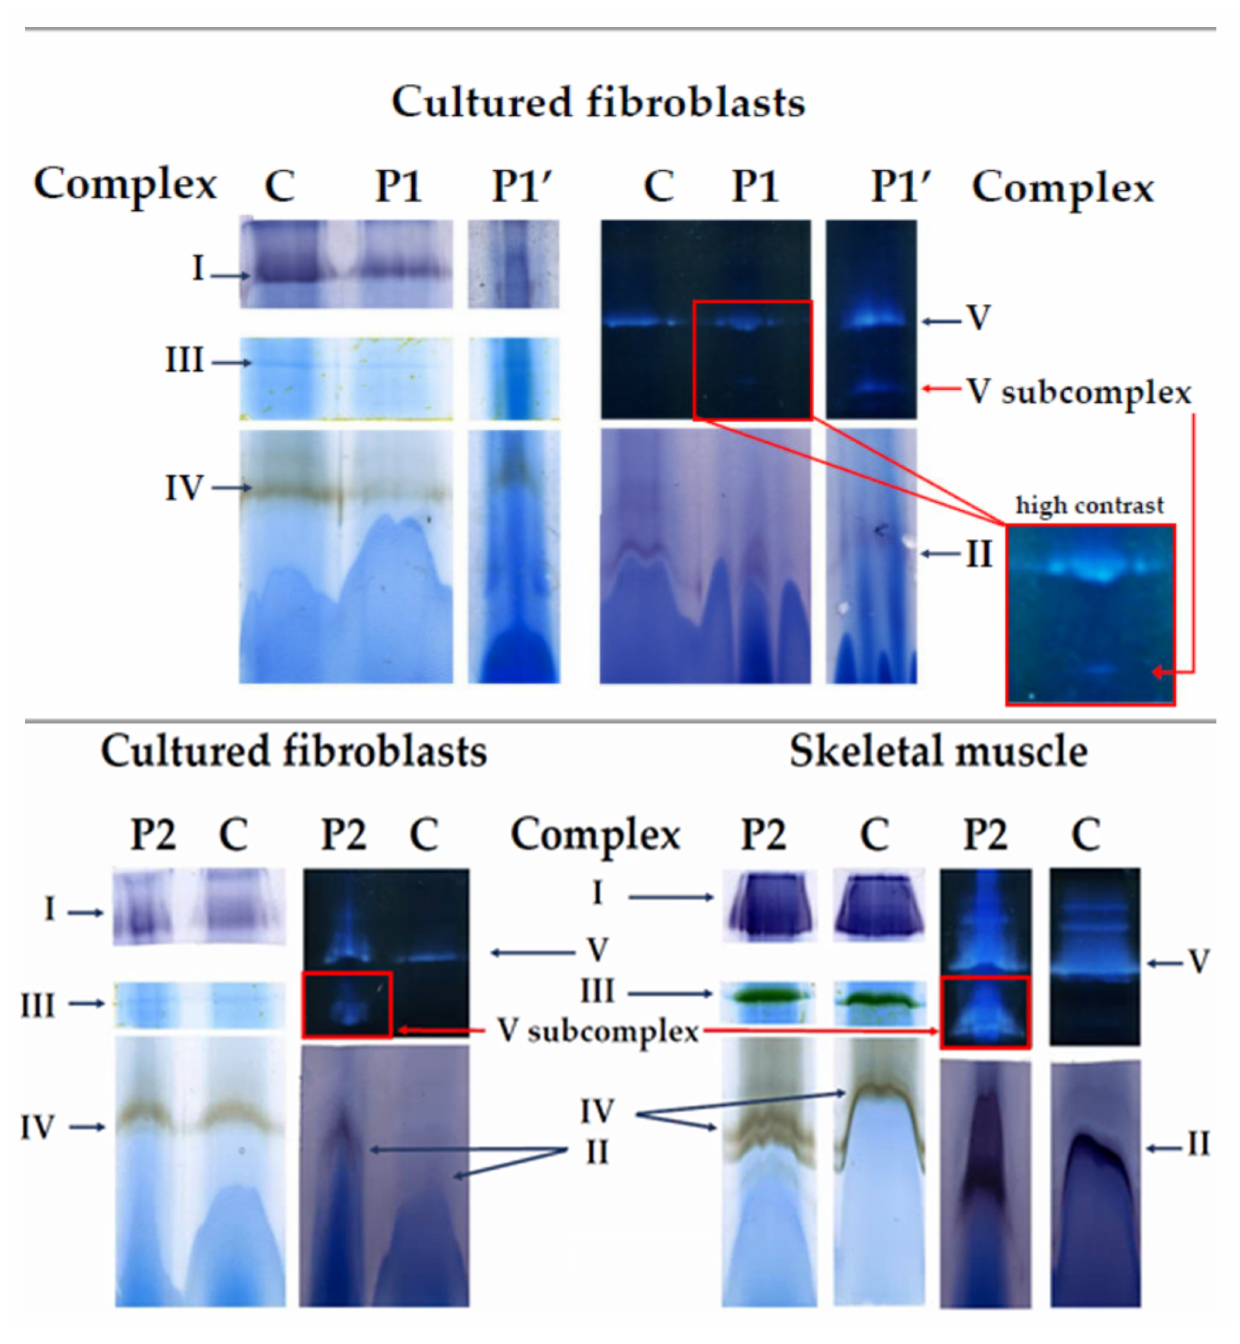
Figure 4. Depicted are the results of BN-PAGE with in gel activity staining. In the upper panel the results obtained from mitochondria isolated from fibroblasts of P1 are depicted. These results were confirmed in a separate, second analysis (P1 (cid:48) ) starting from more material (approximately 55 vs. 45 µ g of mitochondrial protein was loaded. The results for the mitochondria isolated from the fibroblasts and skeletal muscle of P2 are displayed in the bottom panel . In each panel, the result of a tissue specific control sample (C), run in parallel, is shown as well. For P2, the amount of mitochondrial protein loaded was approximately 50 µ g for fibroblasts and 60 µ g for skeletal muscle. Complex V subcomplexes are indicated using red arrows. All other OXPHOS complexes are indicated using blue